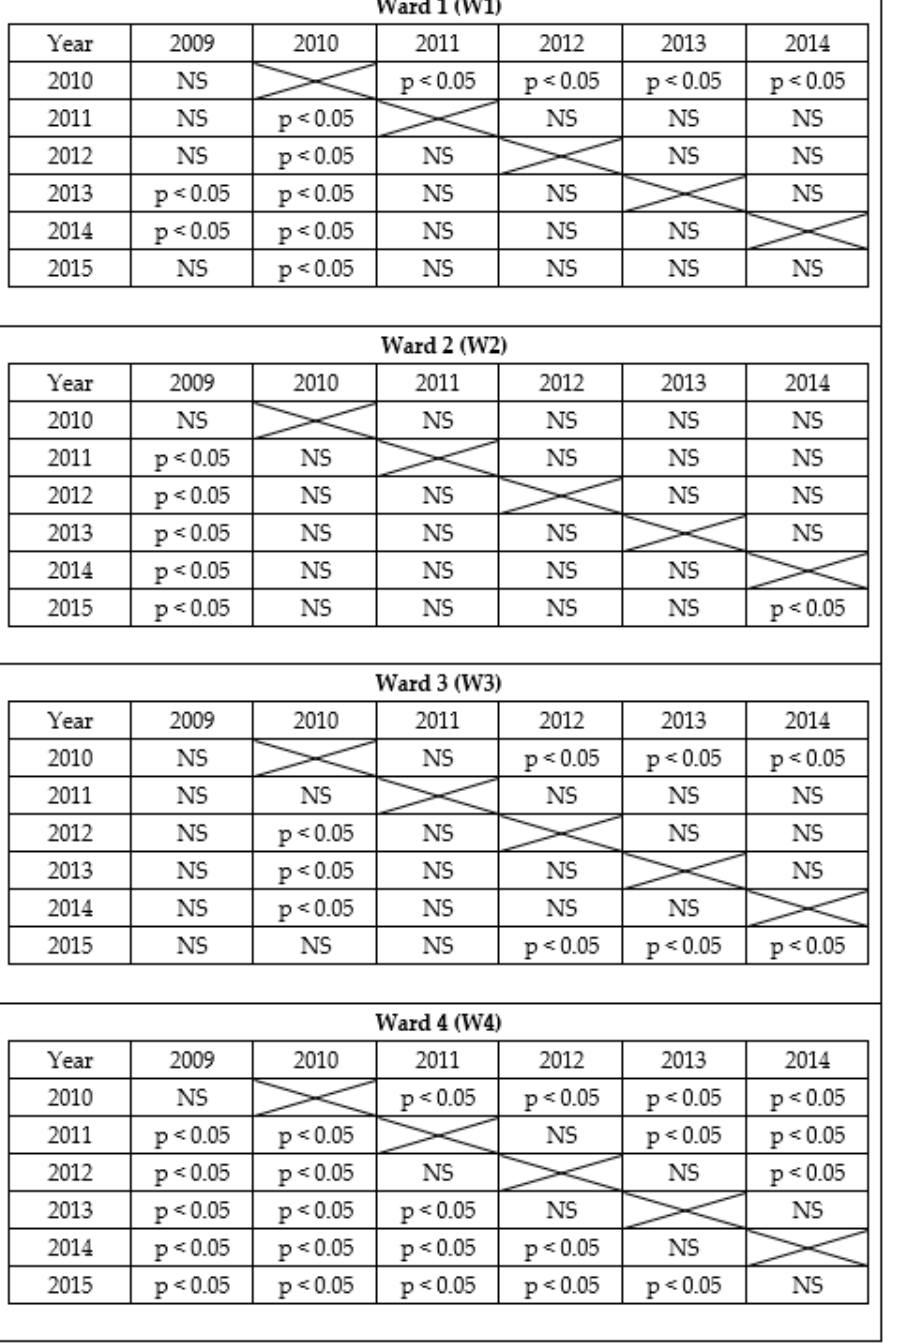
Figure 1. Total assessment between the subsequent years based on average ranks using the post-hoc test.